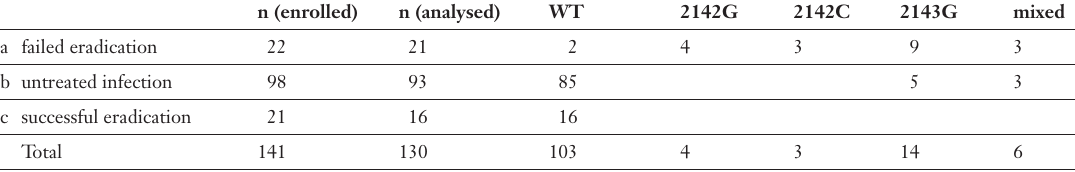
Patient BB with H. pyloripangastritis, subcardial ulcer, treatment failure and persistent infection eight weeks later. Sequencing analysis (left, reverse strand) and clarithromycin- strip (right) of the antrum biopsy in March (a, upper pan- els) and May 2002 (b, lower panels), indicating a mixed WT/mutant popula- tion before therapy for the locus 2143, with A/T roughly equal to G/C and a pure mutant situation after therapy. zyme digest with Mbo2 and Bsa1, single strand conformational polymorphism (SSCP), DNA se- quencing and line probe reverse hybridisation (fig- ures 1 and 2). The restriction enzymes Mbo2 and Bsa1 cut when 2142 or 2143 are mutated from A to G, respectively. SSCP yielded specific band shifts for the mutations A2142/43G in the poly- acrylamide gel (downward band shift and a widely spaced minor band above for A2142G and nar- rowly spaced double bands for A2143G). Both methods do not resolve the mutation A2142C. We thus decided to first apply DNA sequencing with the advantage of an internal control by the reverse